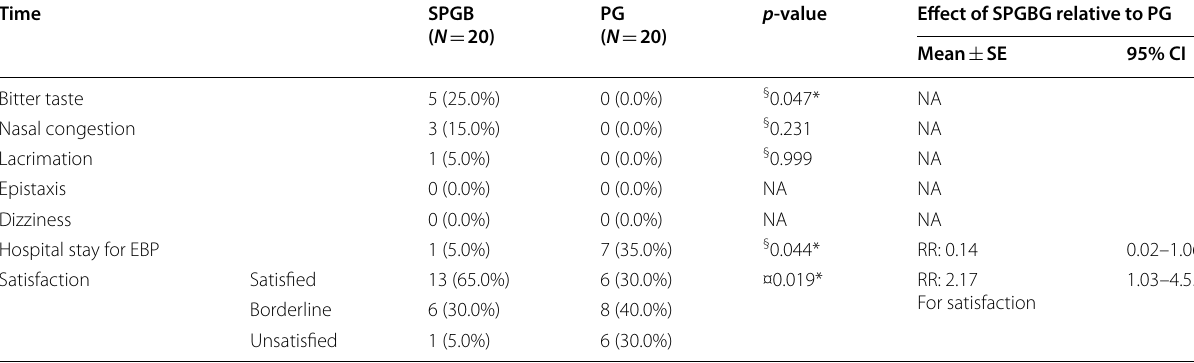
Table 5 Comparison regarding adverse effects, hospital stay, and patients’ satisfaction